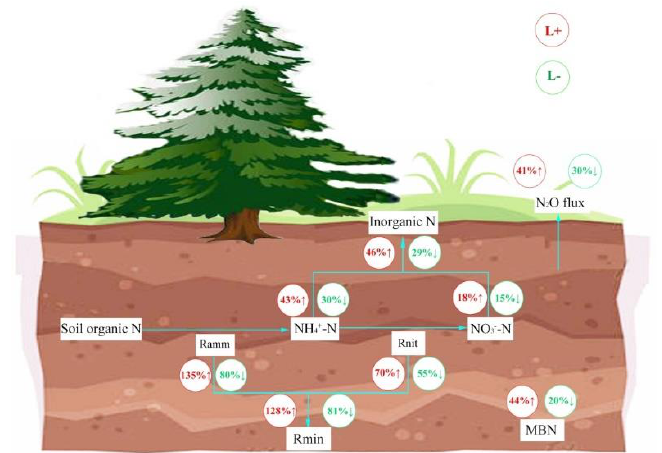
Figure 9. Potential mechanisms of the e ff ects of litter manipulations on 0–20 cm layer soil N dynamics in the Larix gmelinii forest in the Daxing’an Mountains, Northeast China.